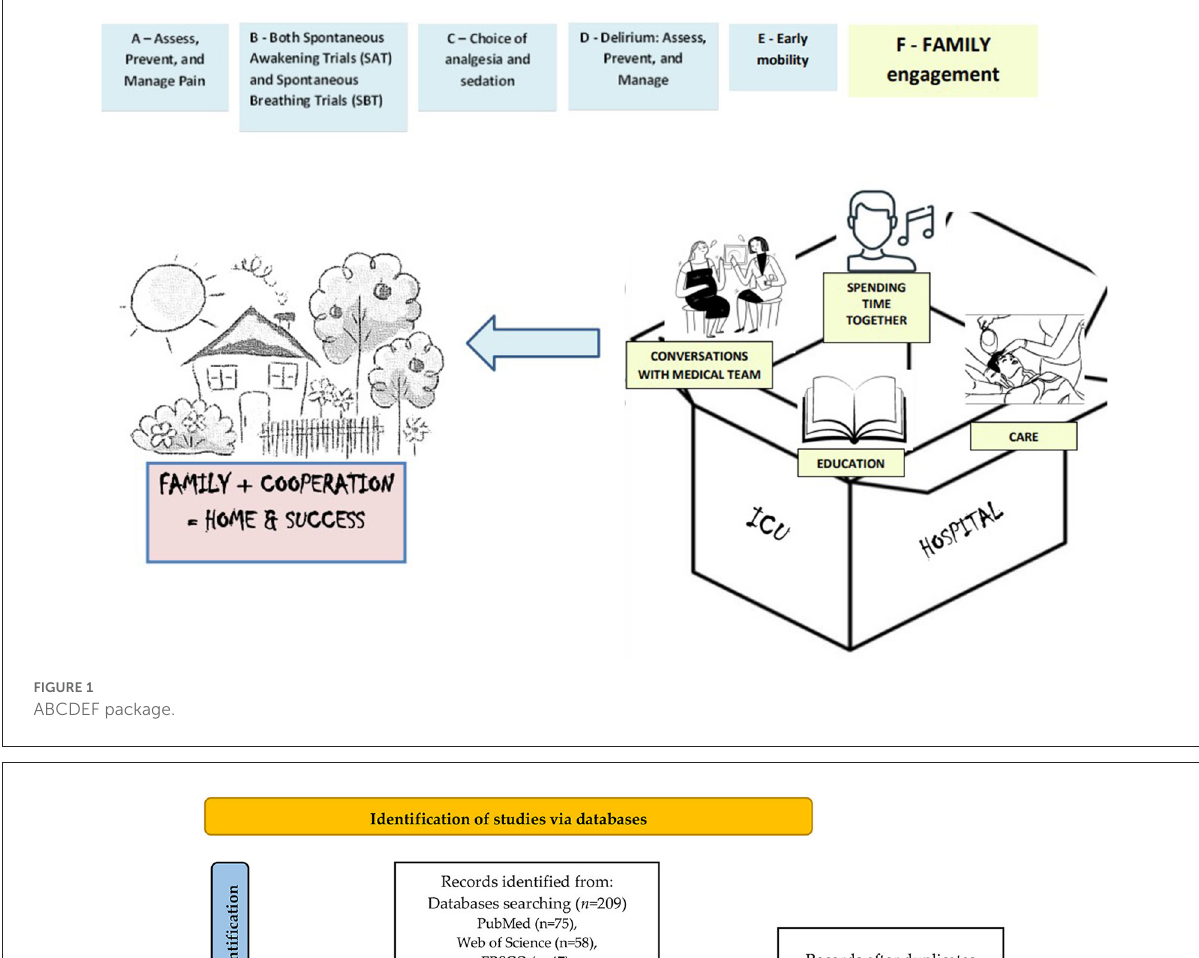
FIGURE1 ABCDEF package.